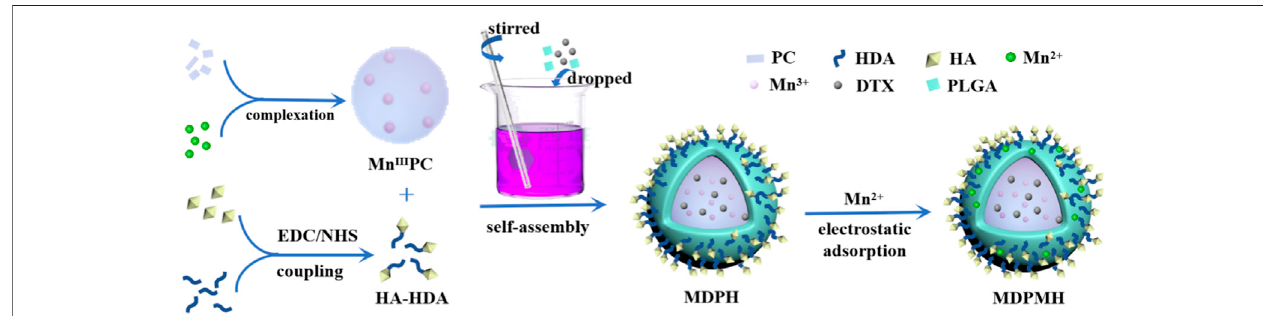
FIGURE 2 | The synthetic route of MDPMH.